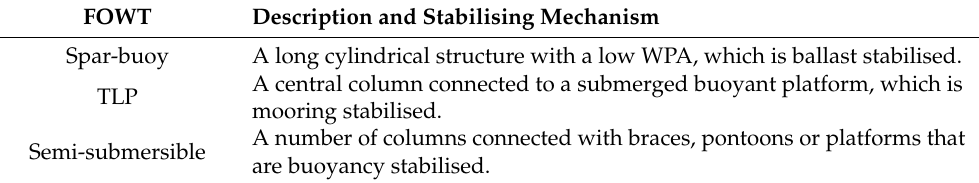
Table 1. FOWT stabilising mechanisms.